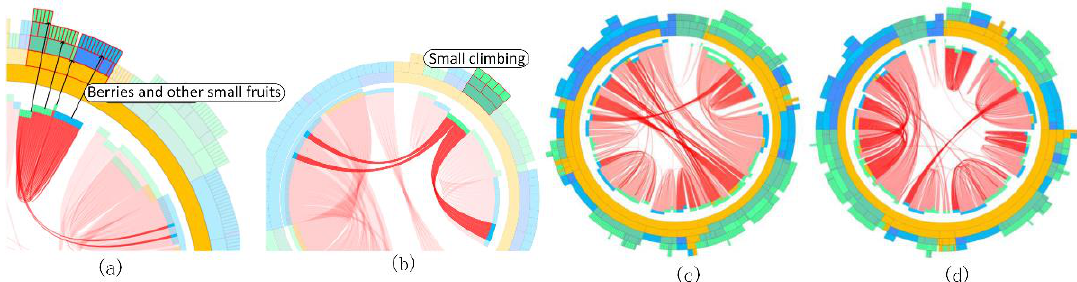
Figure 6. Example of the effect of SECG. ( a ) Node “ Berries and other small fruits ” and its relations in root node view. ( b ) Node “ Small climbing fruits ” and its relations in node “ Fruit ” view. ( c ) SECG effect with the child nodes sorted by: S1_Only, S1_Other, Both, S2_Other, and S2_Only. ( d ) SECG effect with the child nodes sorted by: Both, S1_Only, S1_Other, S2_Other, and S2_Only.